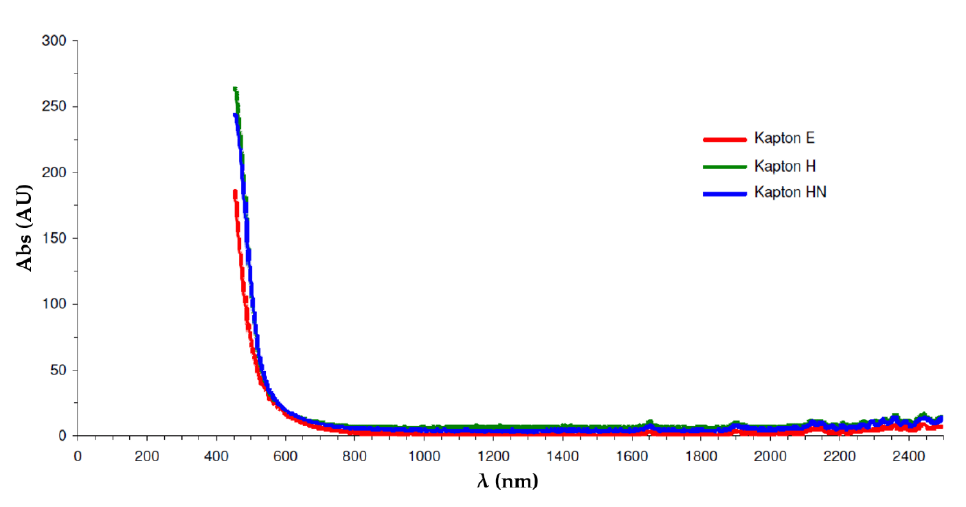
Figure 4. Optical absorbance of some common polyimide polymers.